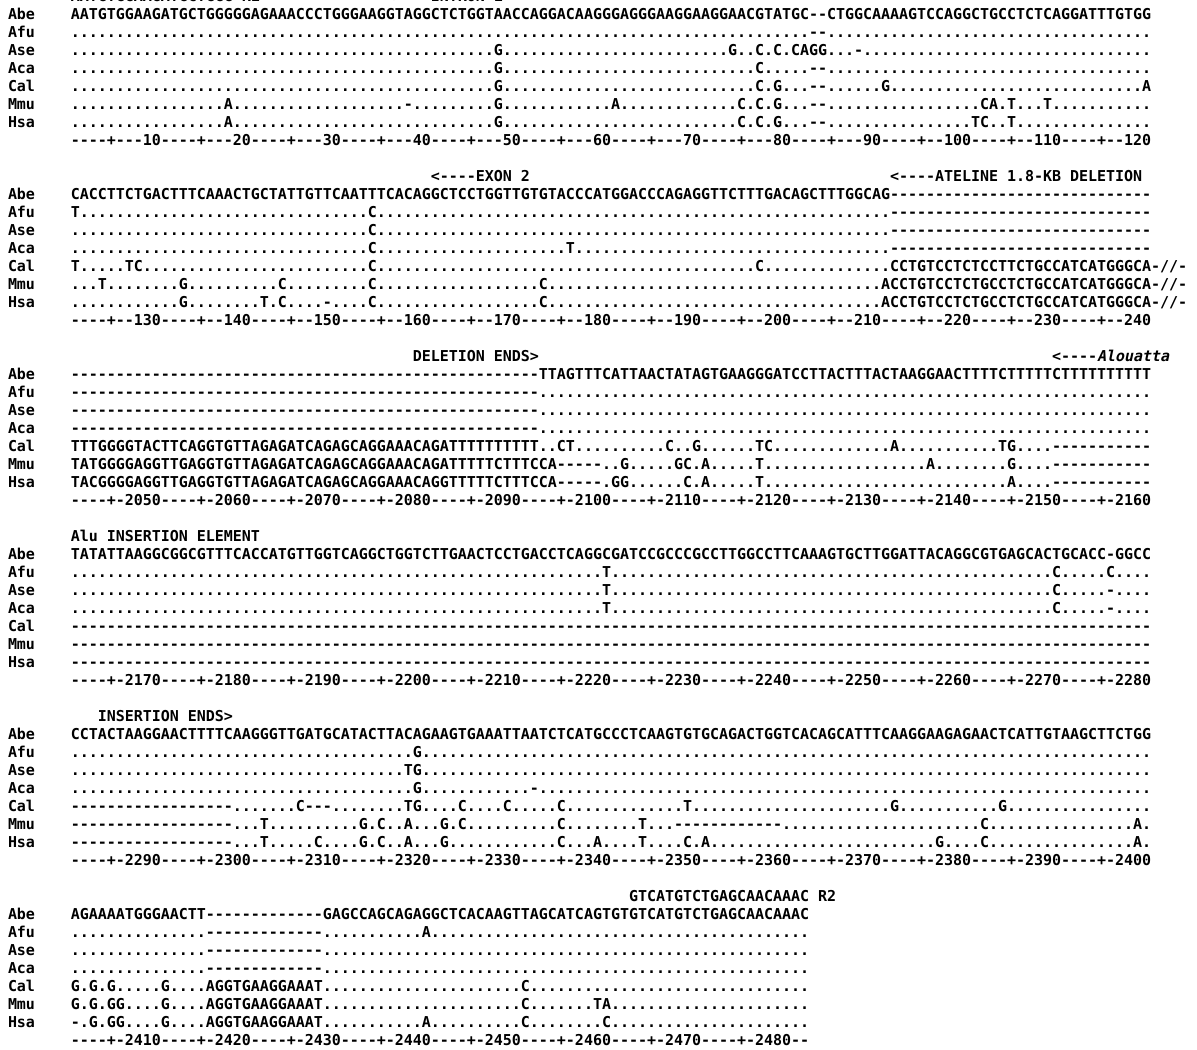
Figure 3 - Aligned DNA sequences of the g 1 -globin pseudogene corresponding to the region between the R1 and R2 primers in four simian genera, including four Alouatta species (see abbreviations in Table I). Dots indicate the same nucleotide as that found in the first (Abe) sequence, and dashes designate gaps resulting from insertions/deletions in the alignment. Sequences corresponding to positions 2041-3720 in Cebus albifrons (Cal), Macaca mulatta (Mmu) and Homo sapiens (Hsa) were published by Bailey et al . (1992) and are thus omitted here.